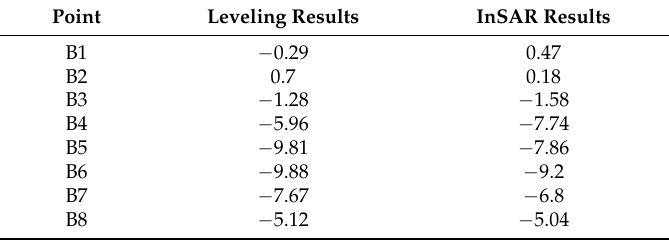
Table 4. The final displacements from leveling and InSAR in Bohai Building (mm).